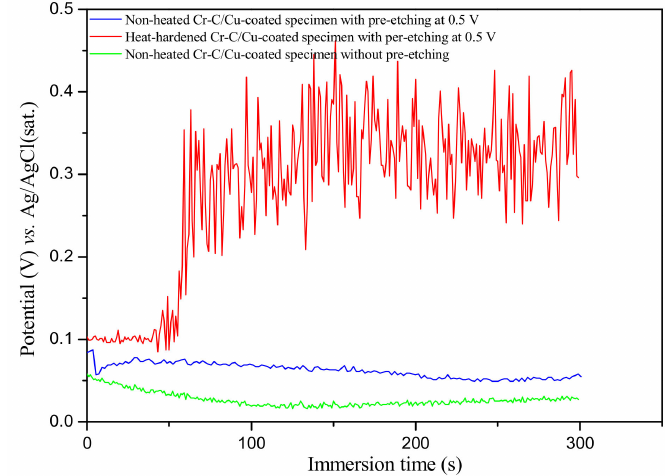
Figure 11. Variation of open-circuit potentials of the heat-hardened Cr–C / Cu-coated sample pre-etched at 0.5 V and the non-heated Cr–C / Cu-coated samples without and with pre-etching at 0.5 V during immersion tests in a 200 g / L CuSO 4 · 5H 2 O and 70 g / L H 2 SO 4